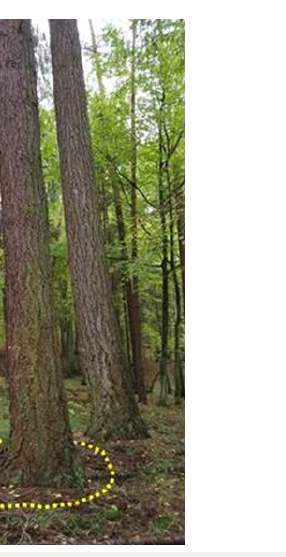
Figure 3 Scheme showing the 0.5-m minimal area around the tree